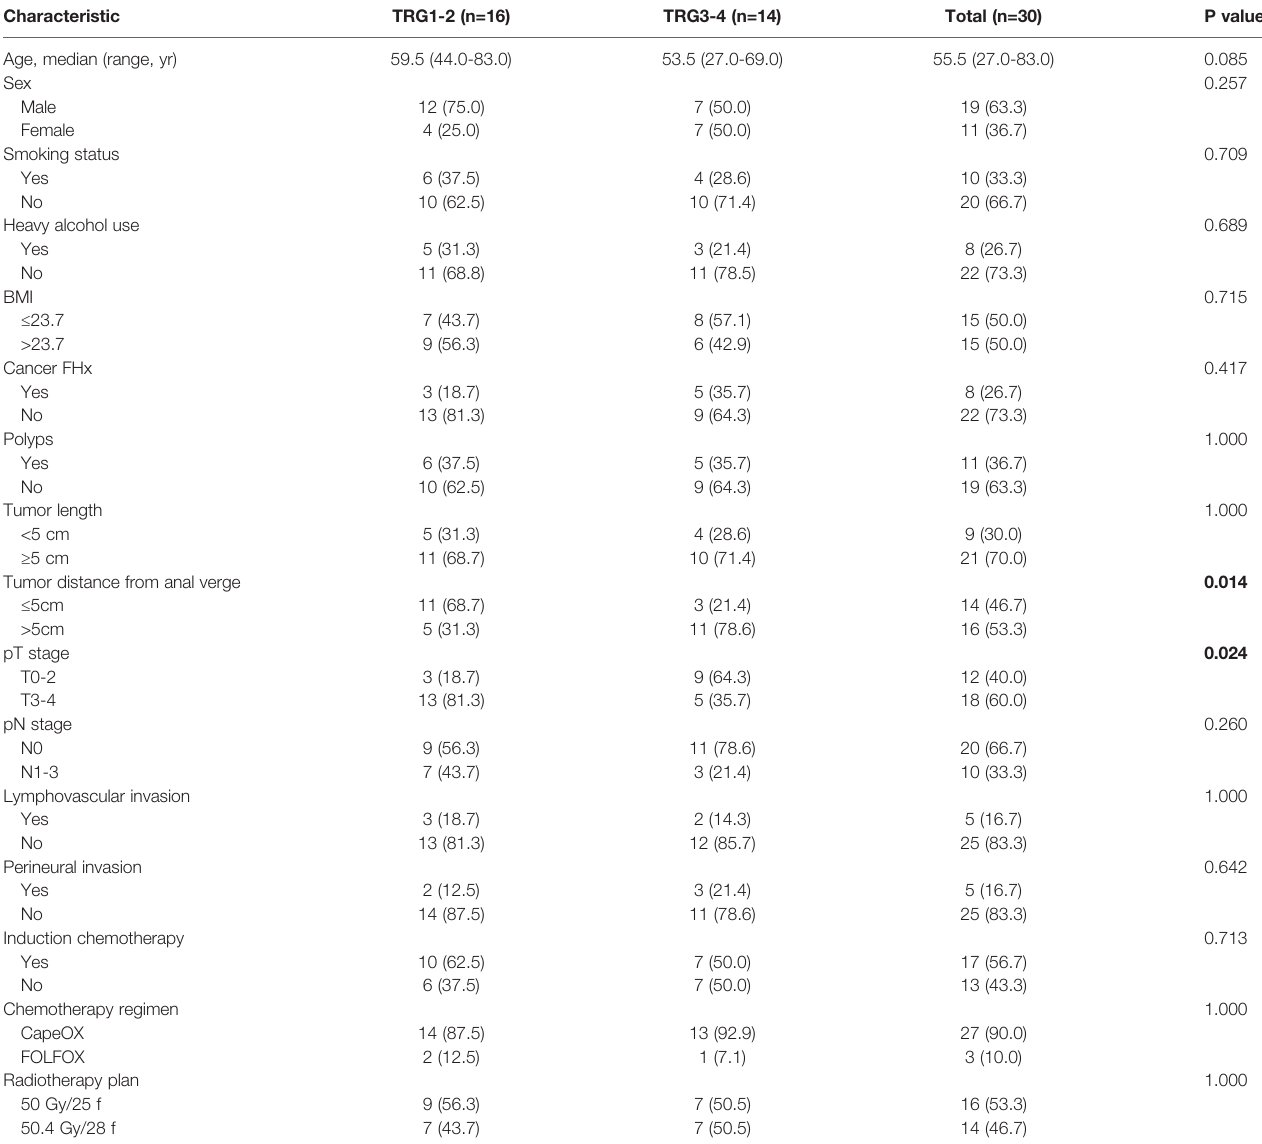
TABLE 1 | Baseline demographic and clinical characteristics of patients. Characteristic TRG1-2 (n=16) Age, median (range,